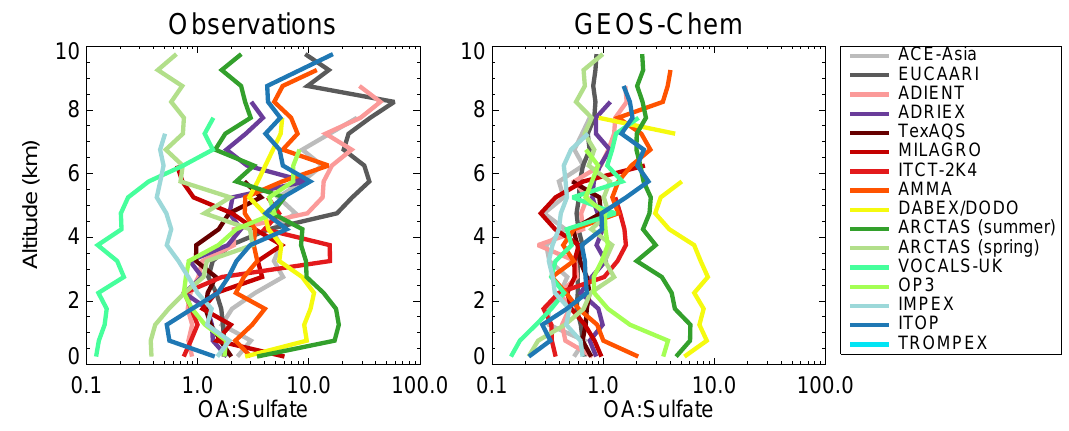
Fig. 5. The vertical profile of observed (left) and simulated (right) mean OA to mean sulfate ratio for 17 field campaigns. Altitudes where sulfate concentrations are reported as zero are not shown.